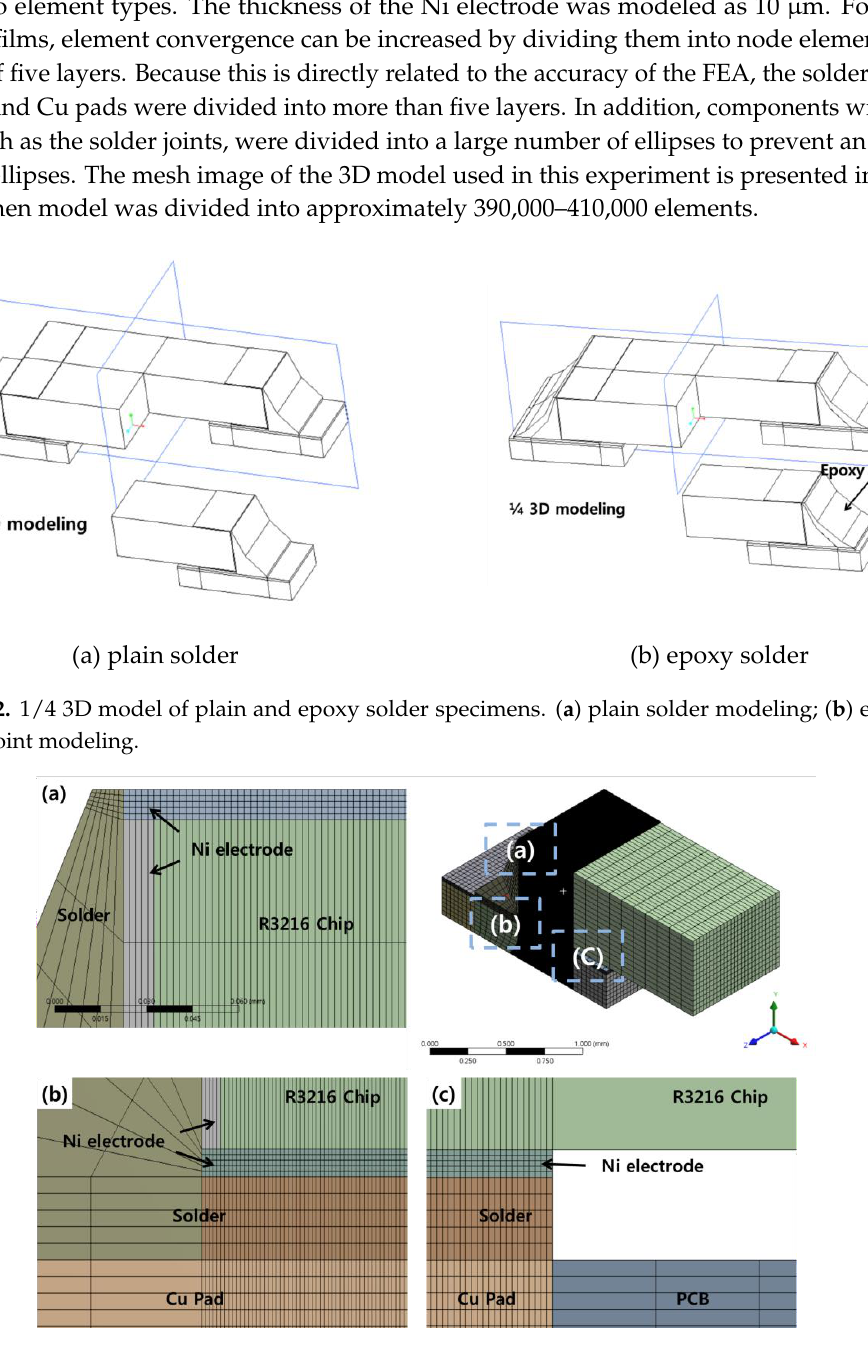
Figure 3. Mesh of a plain solder joint for magnification of region (a), (b), (c). ( a ) Solder joint fillet; ( b ) Ni layer in solder joint ( c ) End of Ni layer in solder joint.